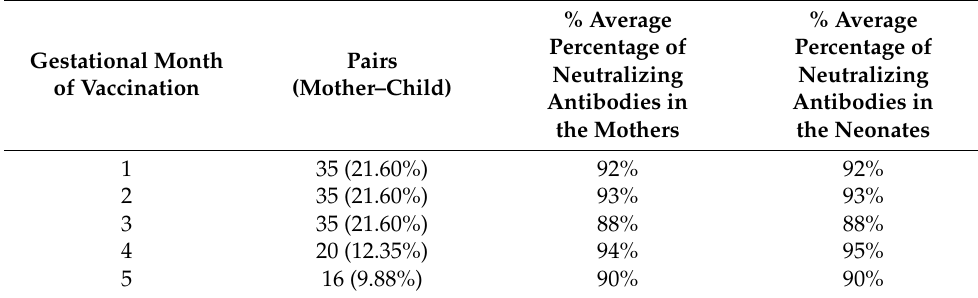
Table 2. Average percentage of neutralizing antibodies detected in the mothers and neonates in relation to the month of